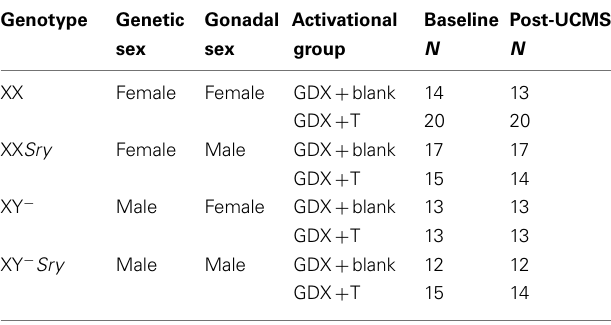
Table 3 |Treatment and size of experimental